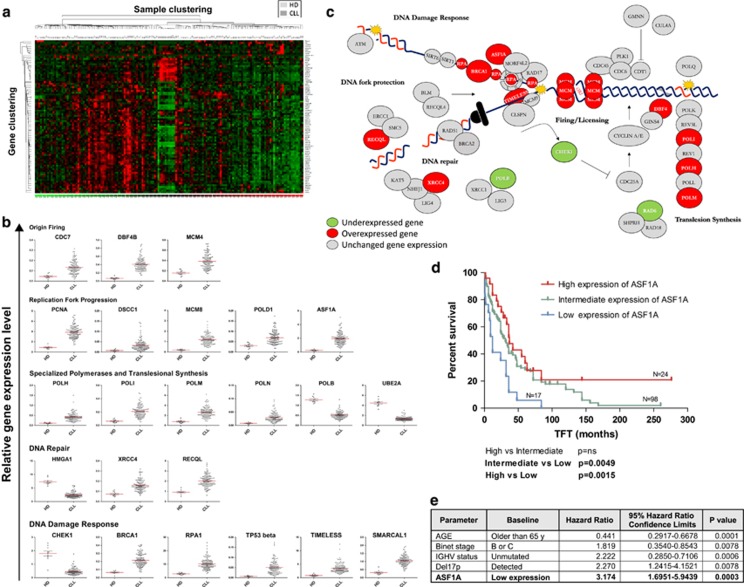
3R gene expression in CLL and ASF1A clinical implication. (a) Unsupervised clustering of gene expression data. (b) 3R genes deregulated in CLL (all P values <0.001). (c) Model of CLL replisome. (d) Kaplan–Meier graph of treatment-free survival according to time since diagnosis. (e) Multivariable analysis of time to first treatment.